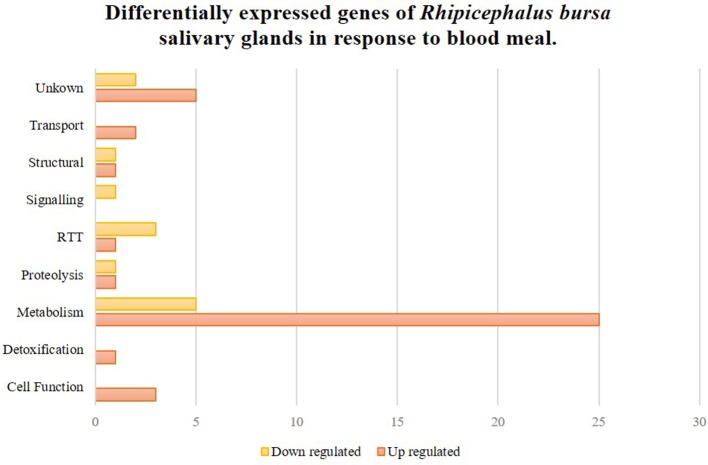
Rhipicephalus bursa SG transcriptional response to blood meal based on Gene Ontology functional classes assignments of encoded proteins. Yellow bars represent down regulated genes, orange bars represent up regulated genes with statistical significance (P < 0.05).